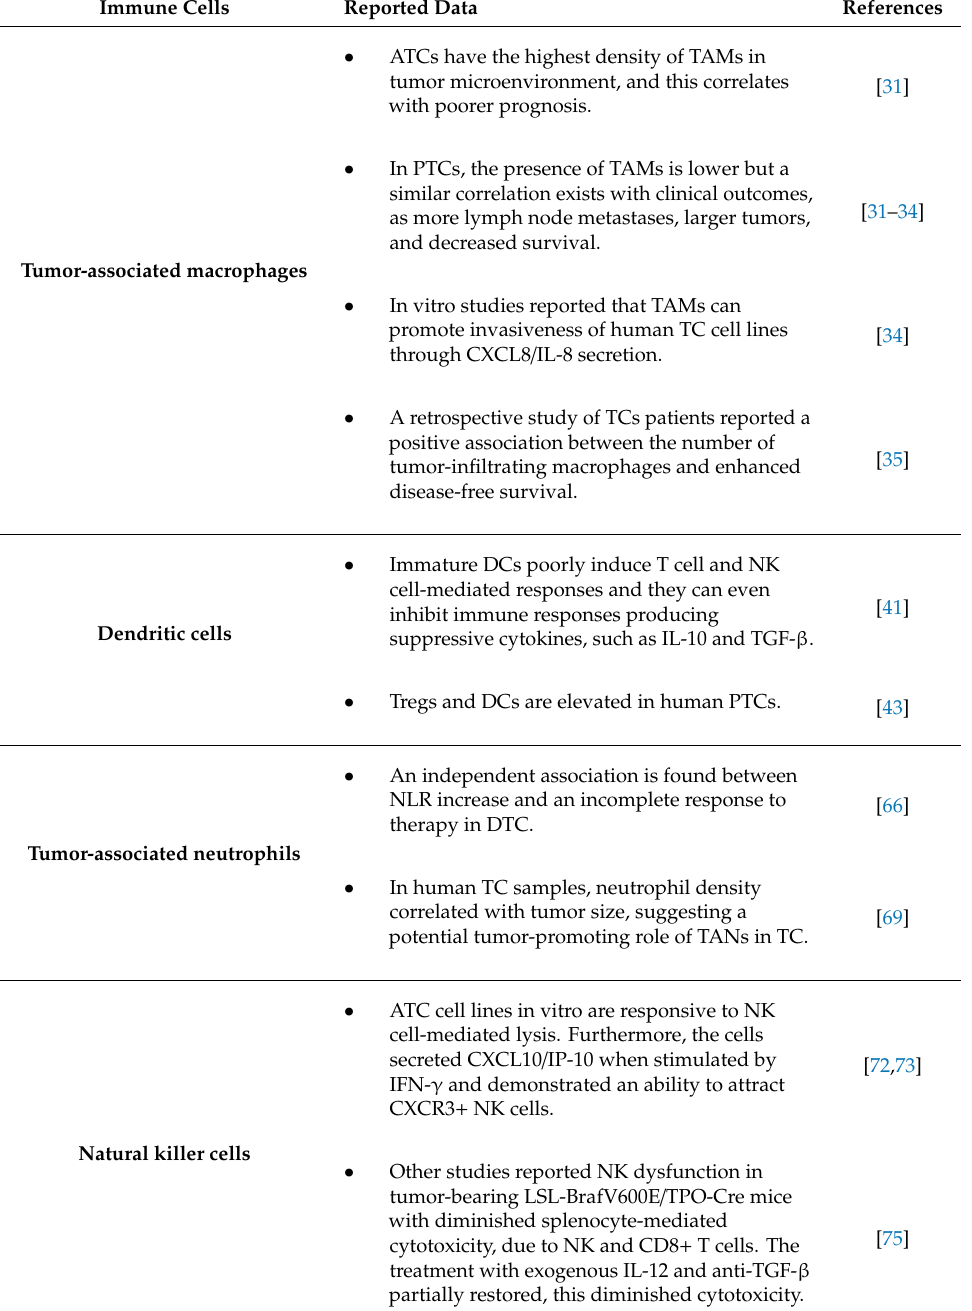
Table 1. Immune cells in thyroid cancer